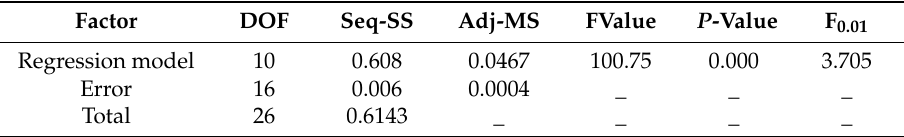
Table 5. ANOVA table for the Grey relational grade (GRG).